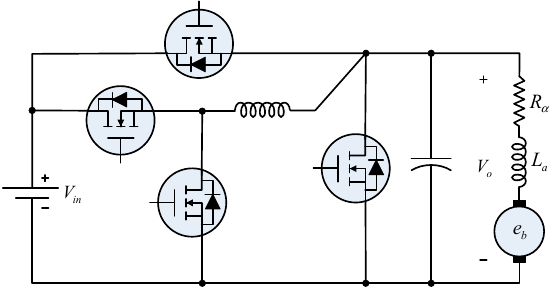
Figure 14. Zero-voltage-transition converter fed DC motor drive .